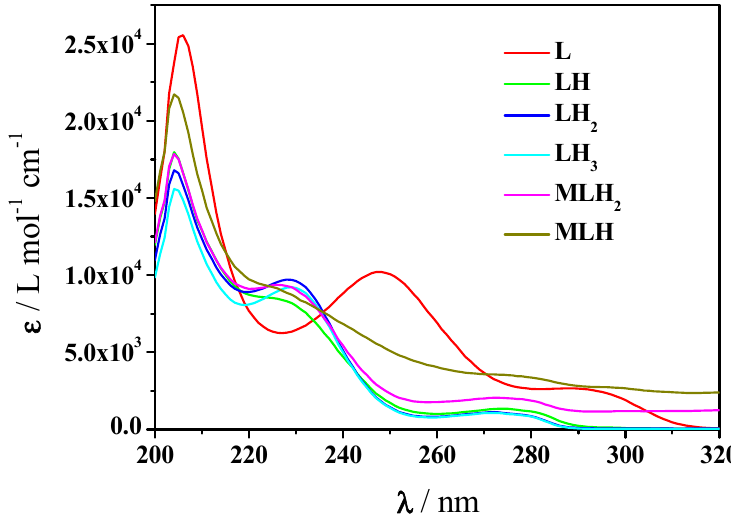
Figure 7. Molar absorbance values of Mn 2+ - Amox complexes and protonated and unprotonated Amox species at t = 25 °C and I = 0.15 mol L − 1 in NaCl (charges omitted for simplicity).